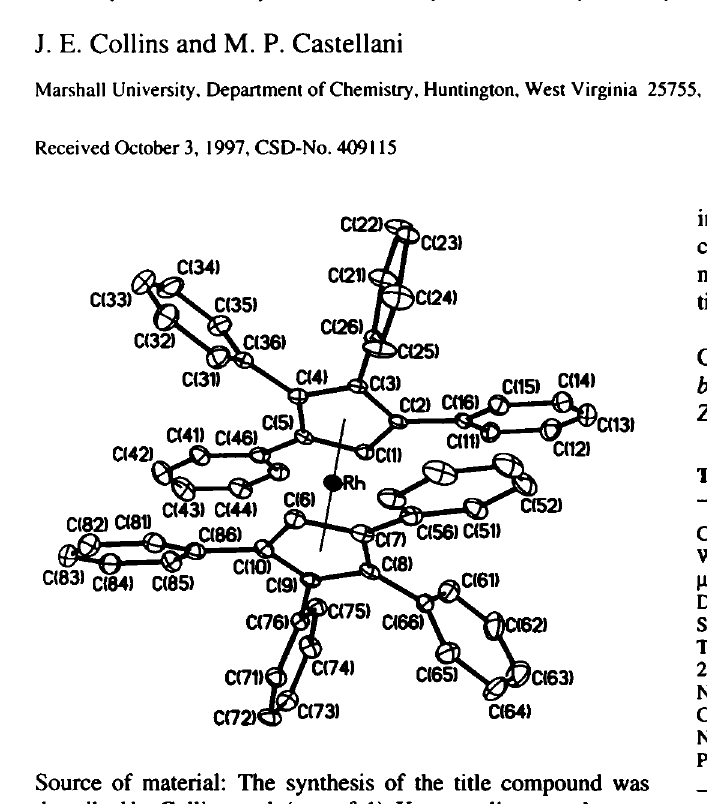
Table 1. Parameters used for the X-ray data collection Crystal: